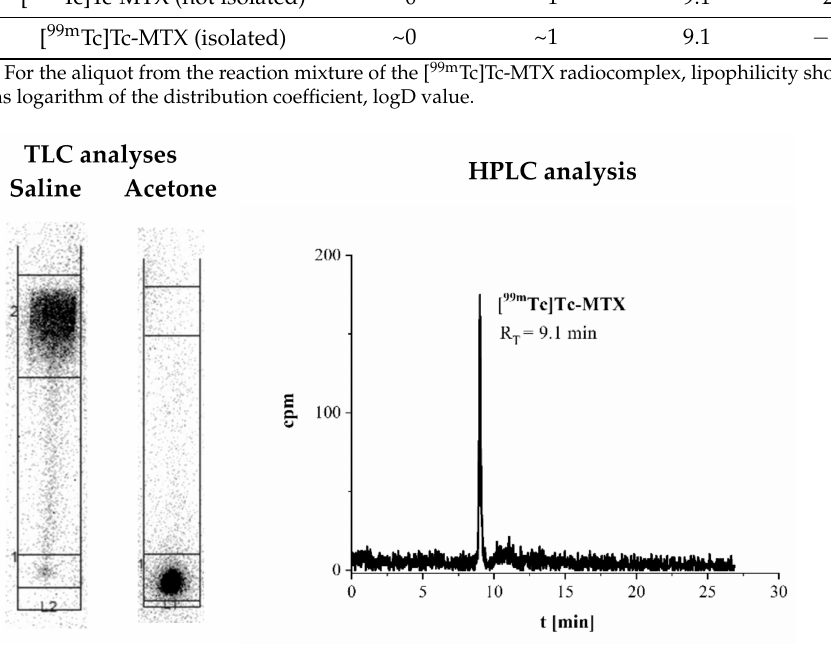
Figure 8. ITLC and HPLC analyses verifying stability of isolated [ 99m Tc]Tc-MTX complex during the lipophilicity